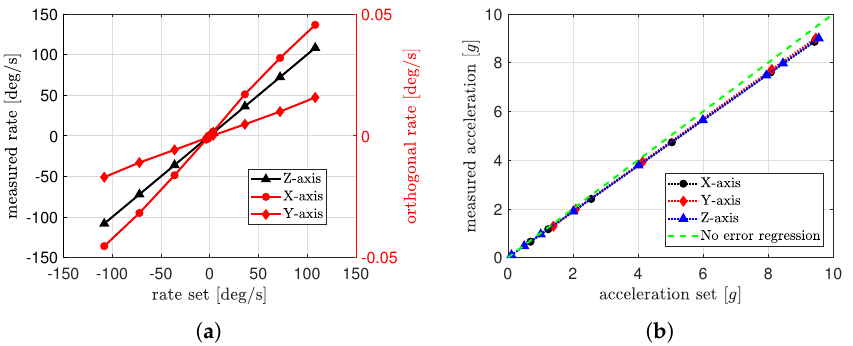
Figure 5. Example of AHRS data analysis. ( a ) Constant angular rate on the Z-axis, ( b ) Dynamic accelerations at